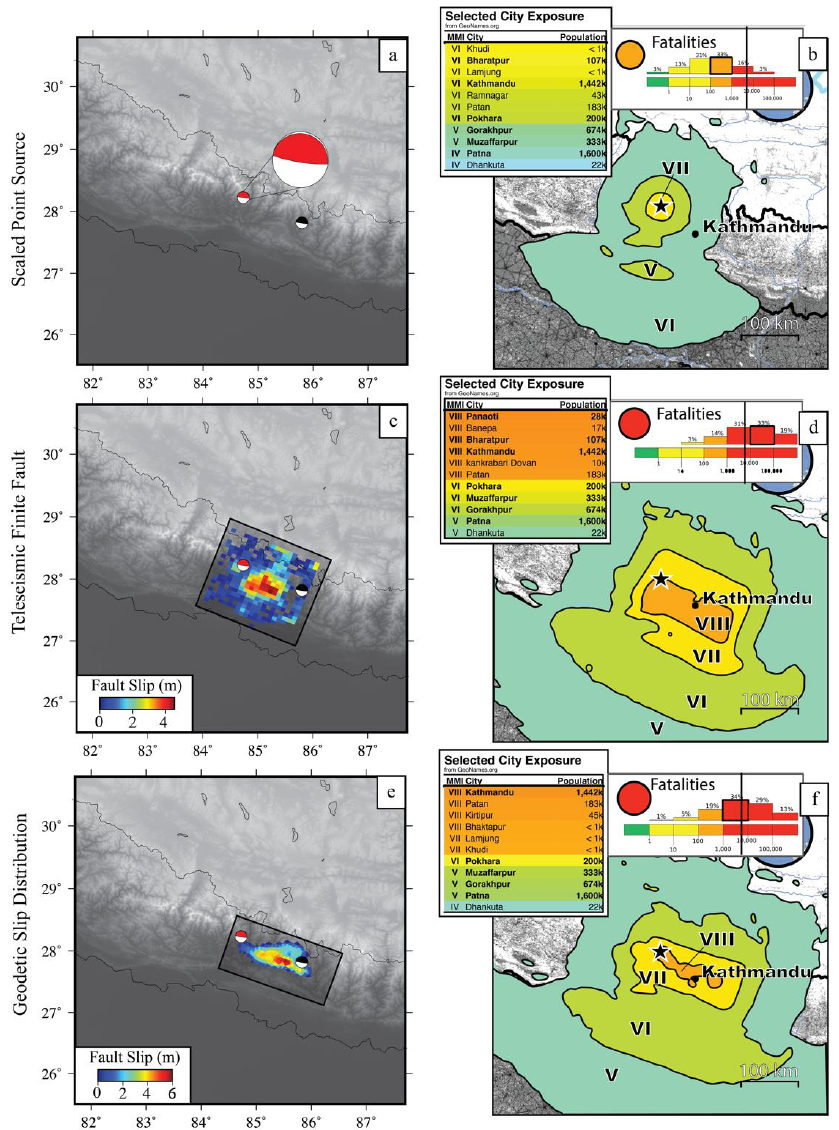
Figure 5. Examples of the evolution of NEIC PAGER reports following the 2015 Gorkha, Nepal earthquake. ( a , b ) Initial earthquake location and W-phase moment tensor solution with the corresponding PAGER report that used a scaled point source solution. ( c , d ) Preliminary teleseismic finite fault model and corresponding PAGER report. ( e , f ) Co-seismic slip distribution derived from GPS and InSAR observations. The slip distribution was used to constrain a revised teleseismic finite fault model that was then incorporated into the shown PAGER update. The vertical black bars in the fatalities subpanel of panels b, d, and e indicate the number of eventual fatalities associated with the Gorkha earthquake (~8,900 as of May 2019). Roman numerals indicate the expected MMI shaking intensities. The black moment tensor indicates the location of the 12 May 2015 M w 7.3 aftershock (Table 1).